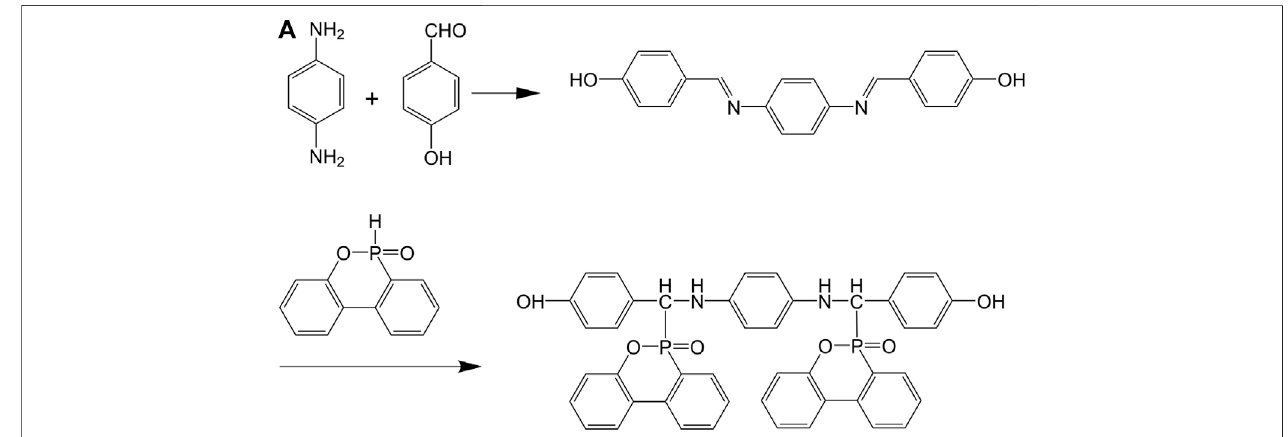
FIGURE 1 | (A) Synthetic roadmap of P-PPD-Ph; (B) FTIR spectrum of the imine-containing compound and (C) P-PPD-Ph-conjugated fl ame retardant; (D) 1 H NMR spectrum of the imine-containing compound and (E) P-PPD-Ph-conjugated fl ame retardant; (F) 31 P NMR spectrum of P-PPD-Ph-conjugated fl ame retardant; (G,H) thermal analysis of the synthesized P-PPD-Ph-conjugated fl ame retardant under nitrogen (N 2 ) atmosphere.